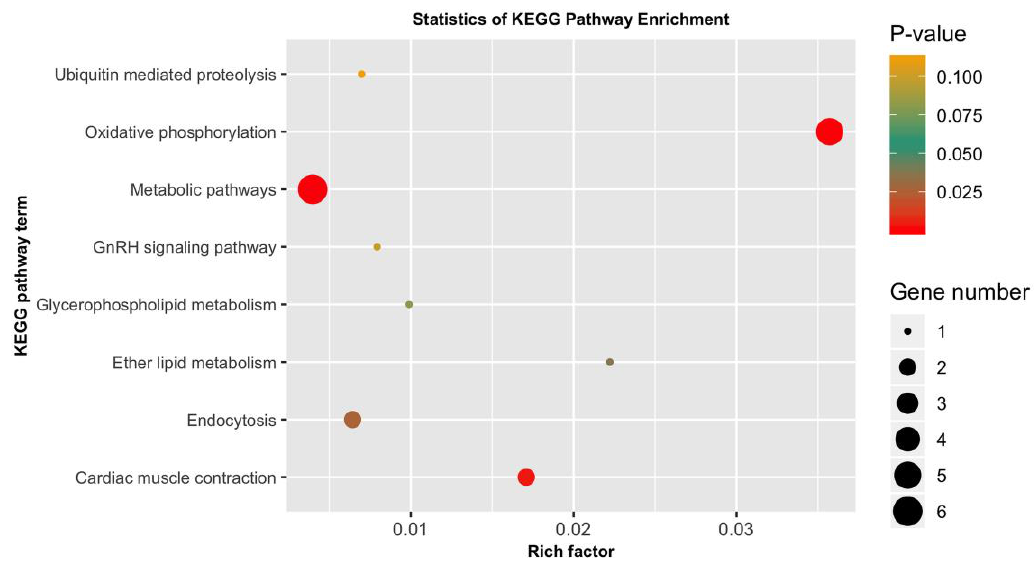
Figure 7. Kyoto Encyclopedia of Genes and Genomes (KEGG) pathways enrichment analysis for the 50 genes encoded by the putatively adaptive SNP loci in P. monodon population.